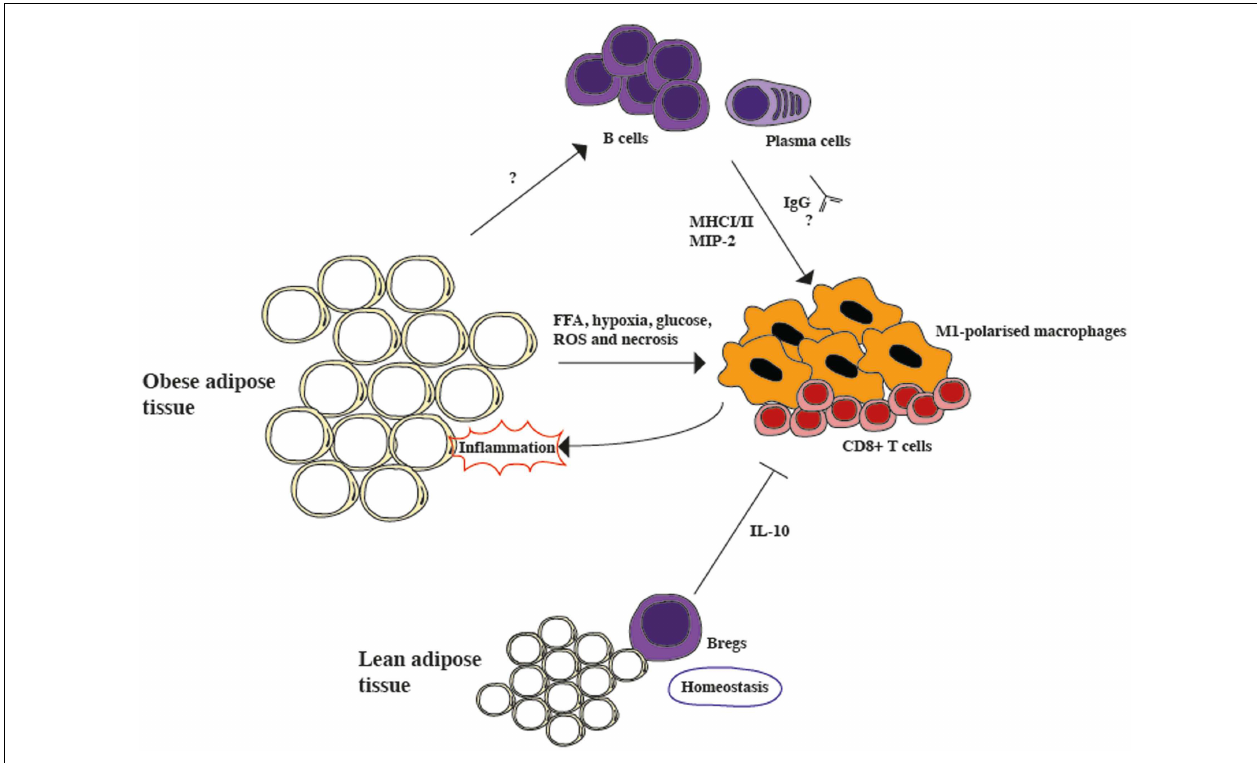
inflammation. B cells are also activated during obesity, although the mechanism is still unclear. During obesity, B cells class-switch and secrete pathogenic IgGs, as well as the macrophage-recruiting chemokine, macrophage inflammatory protein-2 alpha (MIP-2). Furthermore, they also activateT cells via MHCI/II interactions. Overall, it seems that the protective role of Bregs is overcome by the pro-inflammatory role of activated B